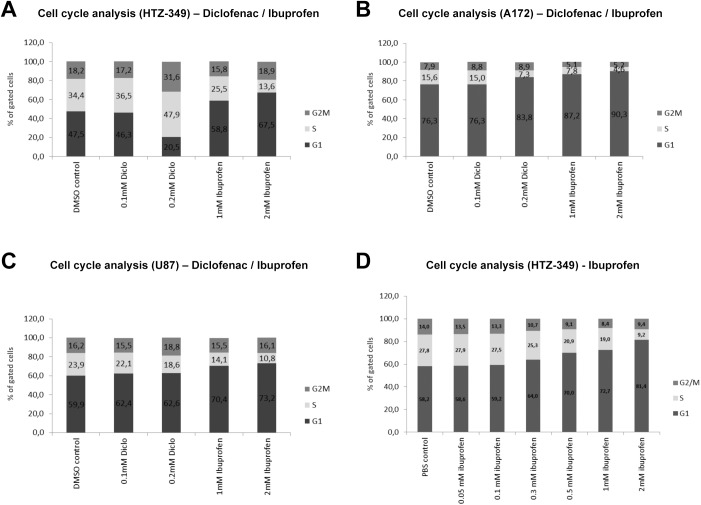
Ibuprofen and diclofenac led to cell cycle arrest at different checkpoints.Human glioma cell lines HTZ-349 (A), A172 (B), and U87MG (C) were cultured in the presence of increasing concentrations of diclofenac (0.1, 0.2 mM) or ibuprofen (1, 2 mM) and respective DMSO controls. Cells were harvested for cell cycle analysis after 48 h of incubation. Proliferation was significantly reduced as measured by a reduced number of cells in S-phase in all conditions except 0.1 mM diclofenac in A172 as well as 0.1 and 0.2 mM diclofenac in HTZ-349. With diclofenac treatment, HTZ-349 and U87MG cells showed an accumulation of cells in the G2/M (U87MG) and S-phase (HTZ-349), whereas A172 arrested in the G1 phase. Ibuprofen generated accumulation of cells in the G1 phase in all cell lines. Additional treatment with 0.05–2 mM ibuprofen (D) confirmed dose-dependent accumulation of HTZ-349 in G1 accompanied by a decrease of cells in S- and G2/M-phase. Bar graphs show mean values of three independent experiments. Histograms are depicted in the supplements (S2 Fig) and show representative plots of each treatment condition.